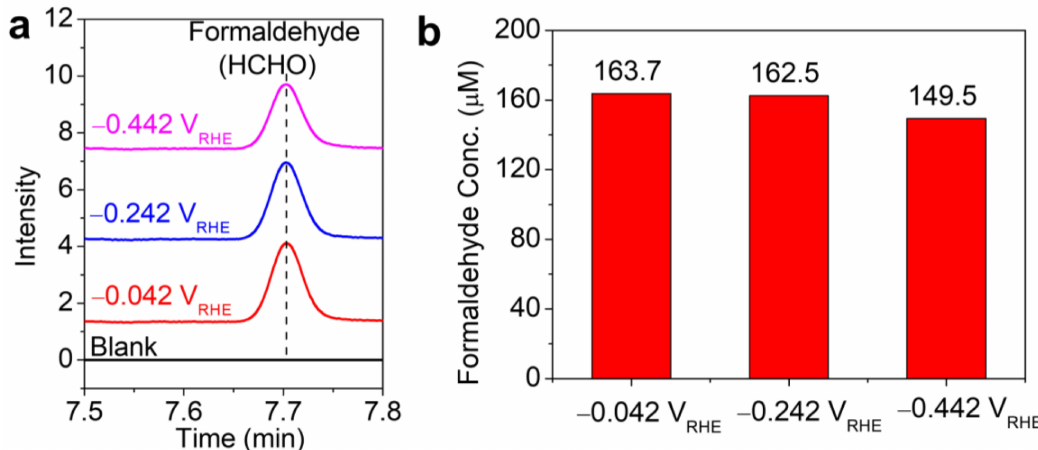
Figure 8. ( a ) GC spectra and ( b ) the corresponding product concentration for electrochemical CO 2 reduction by CN/FTO-520 film in CO 2 -saturated 0.5 M KHCO 3 solution at different applied potentials for 3 h.